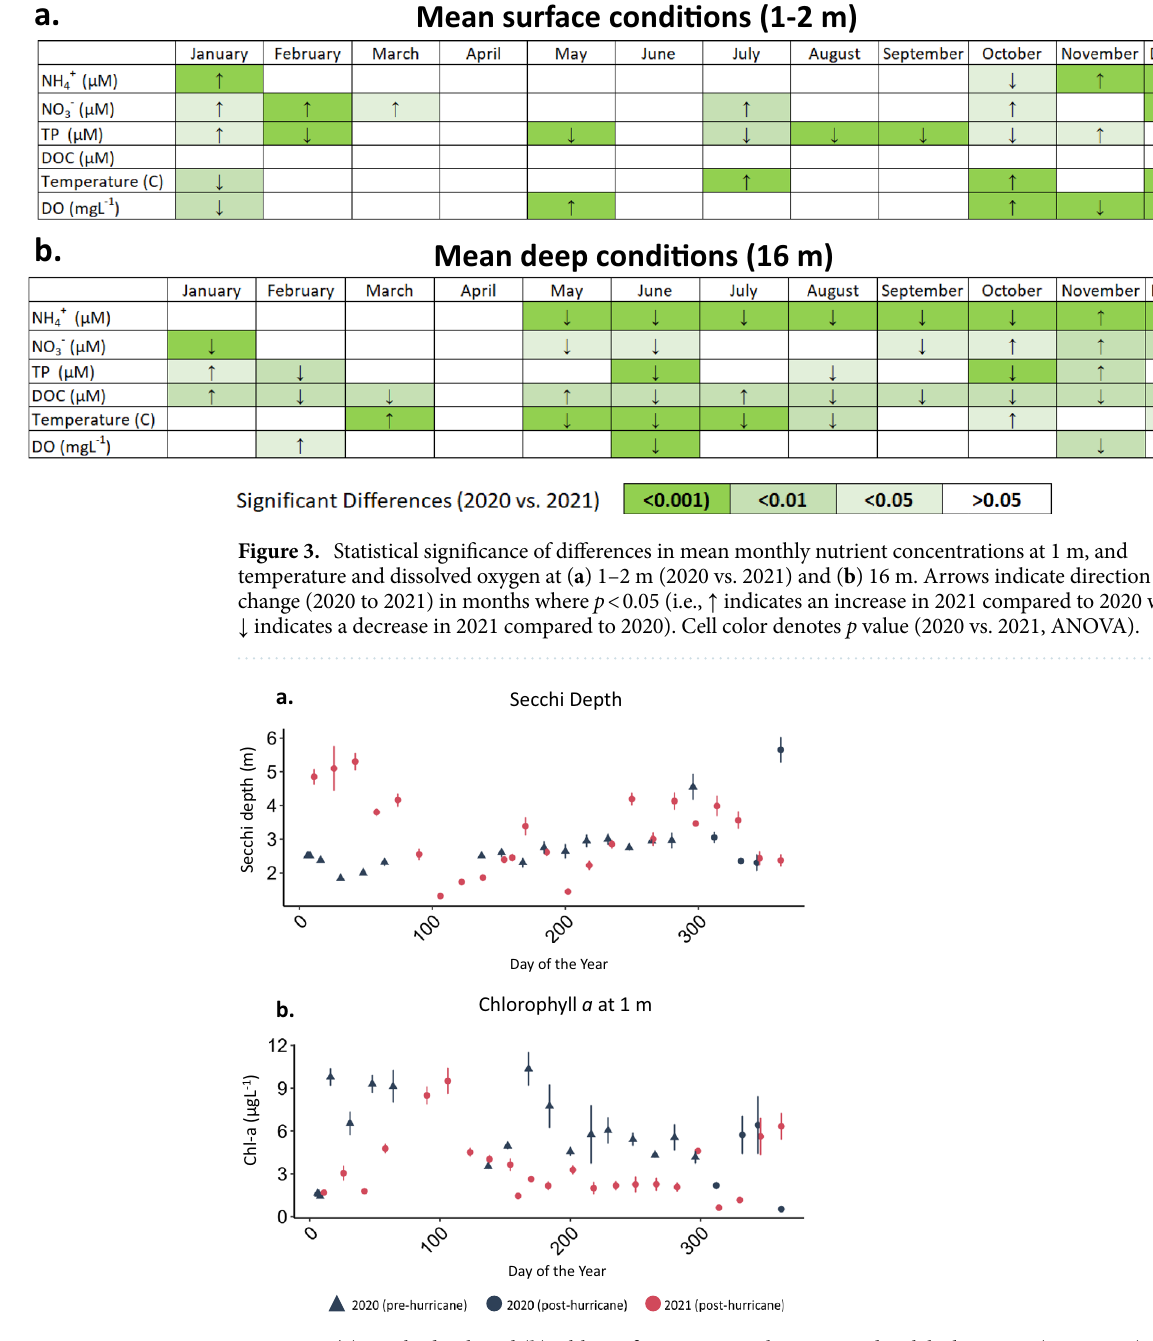
Figure 4. (a ) Secchi depth and ( b ) Chl-a at five continuously monitored in-lake locations (mean ±